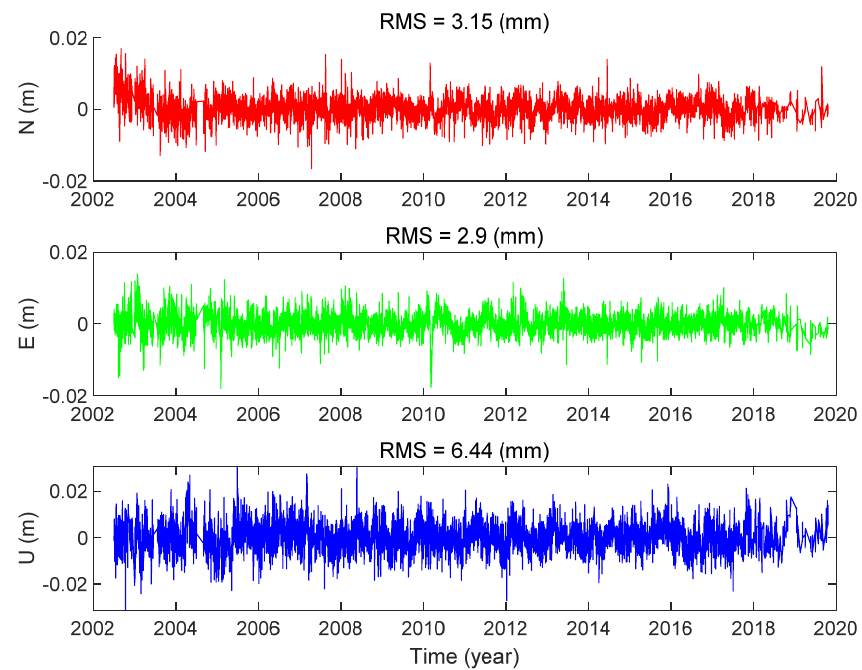
Figure 20. Residuals of ANTC using ITSM adding velocity discontinuity.